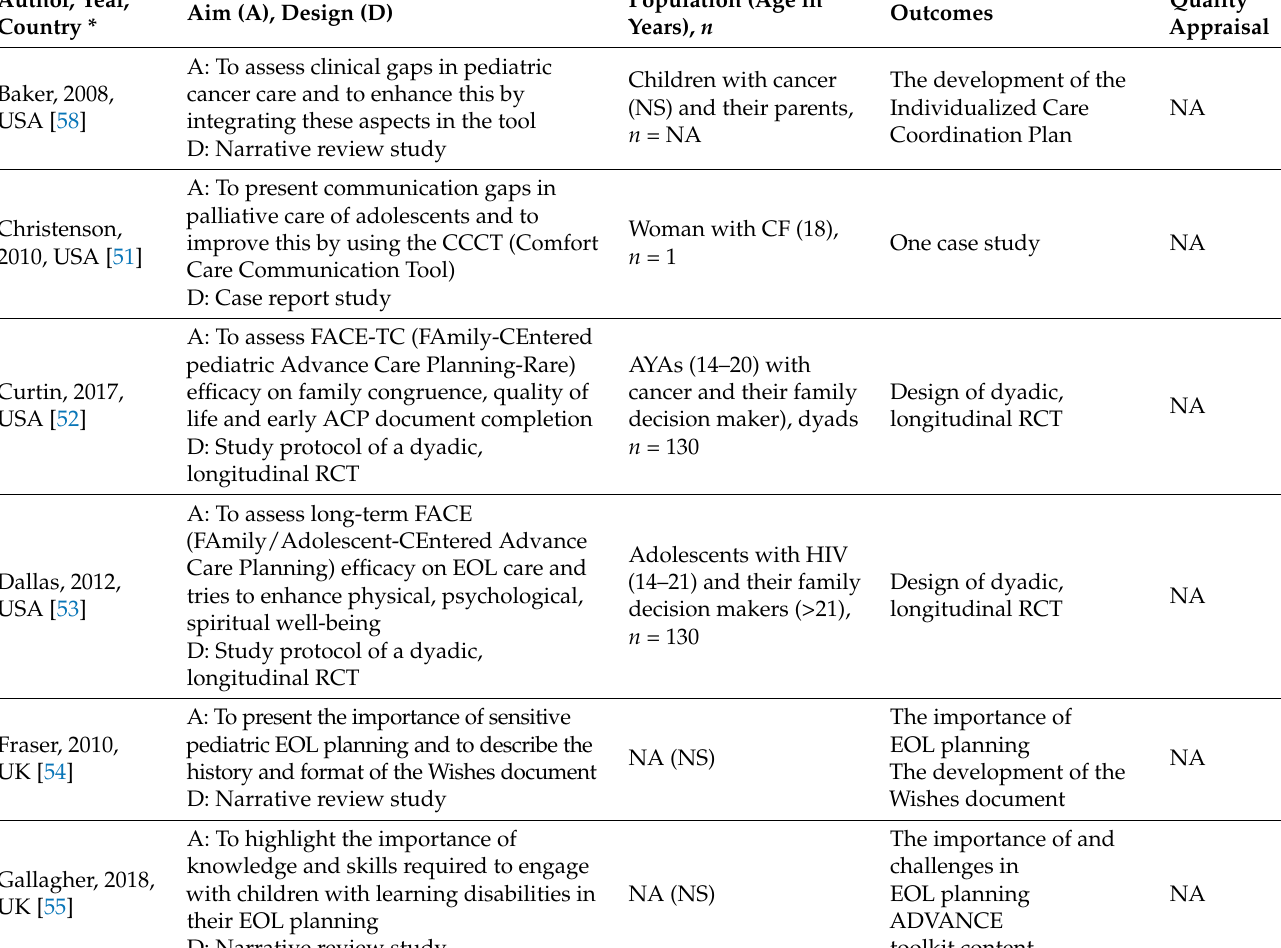
Table 6. Evidence from descriptive